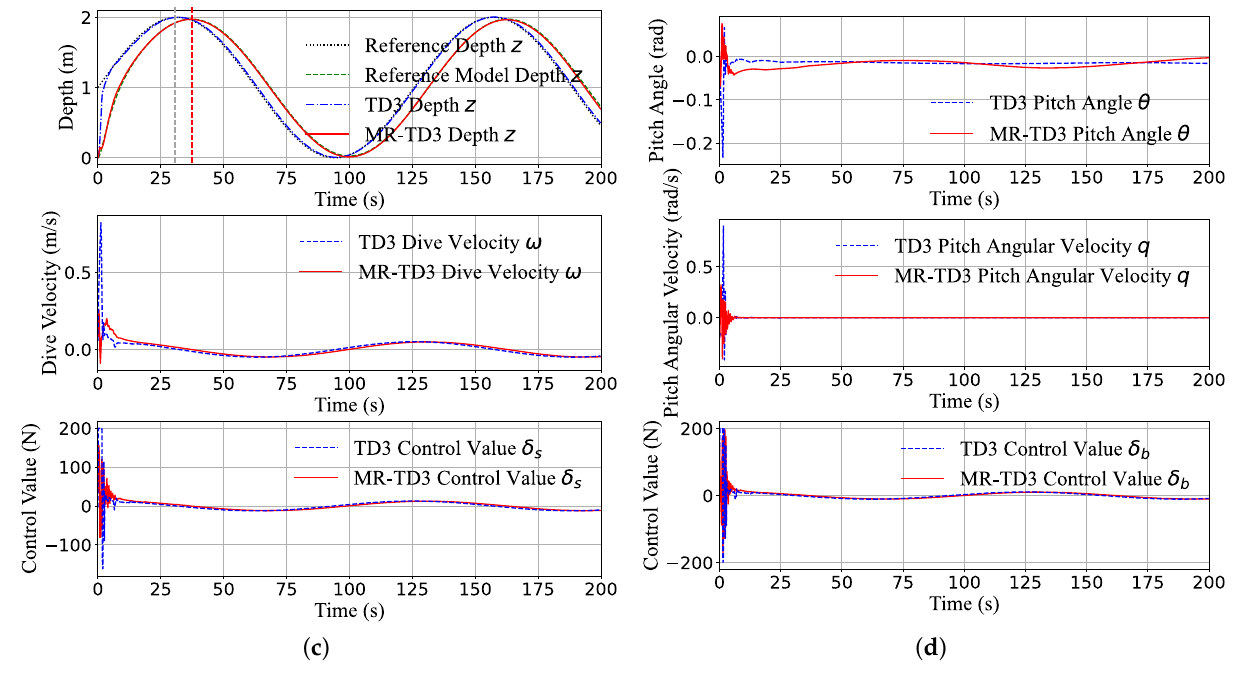
Figure 7. The depth channel transition of the system states (z-position, dive velocity, pitch angle and pitch angular velocity) and control command during the step response ( a , b ) and sine wave response ( c , d ). The maximum actuator command is 200 N . It can be seen that the TD3 method tends to provide a full control command, which is unacceptable in real machines. In contrast, the MR-TD3 command is smoother and can eliminate the overshoot significantly.